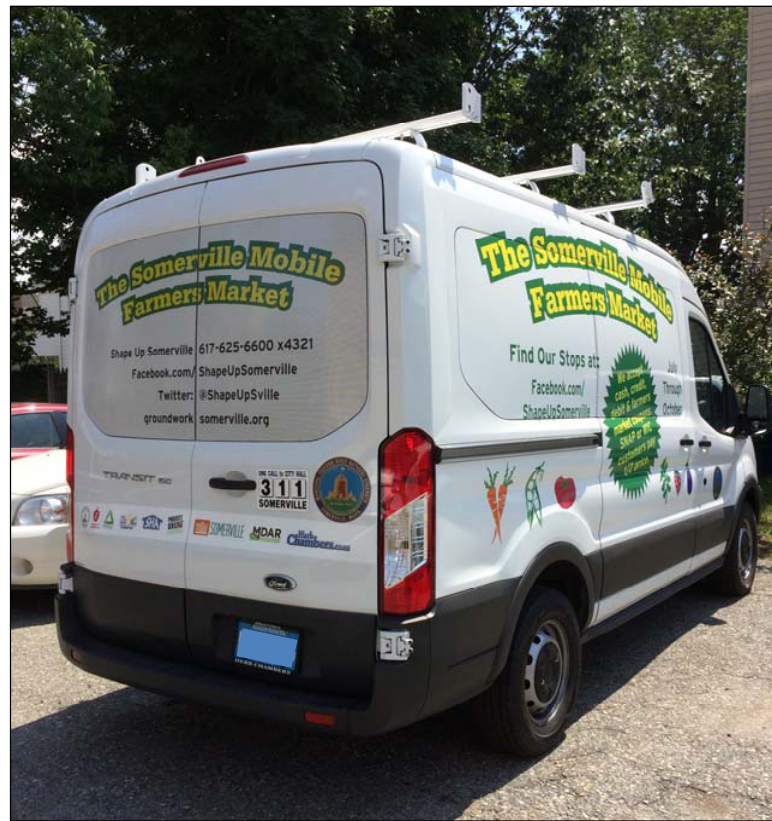
Figure 1. The Somerville Mobile Farmers’ Market van was provided by Massachusetts Department of Agricultural Resources grant and Herb Chambers Car Dealership